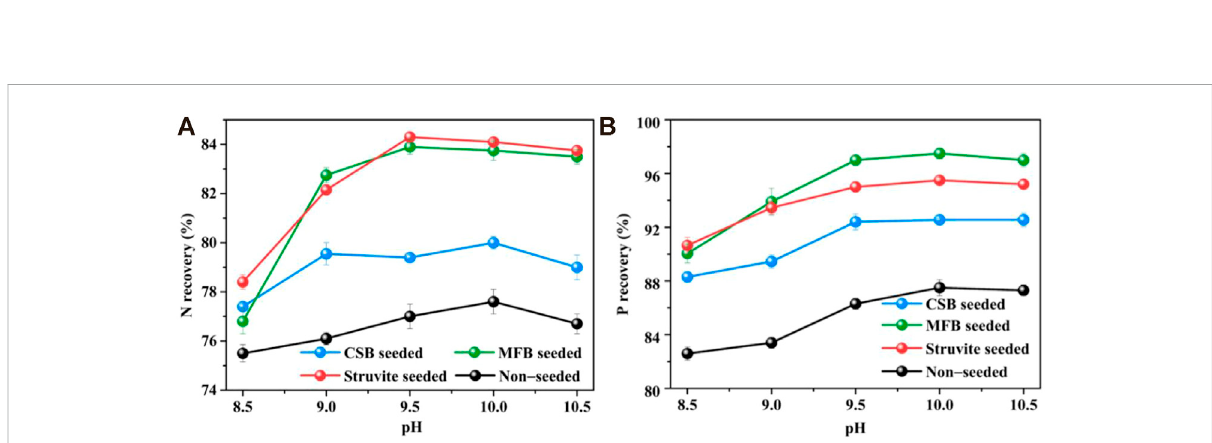
(Figure 2C). The tiny particles on the surface may come from metals (such as K, Ca, and Al) present in the biomass precursors (Chen et al., 2018; W ą drzyk et al., 2021). The smooth fl ake structure with a length of 5 – 10 μ m and a thickness of 0.5 μ m can be seen in SEM images of CSB (Figure 2D). The SEM image of struvite shows the typical morphology of phosphates reported (Figure 2E) (Maqueda et al., 1994).